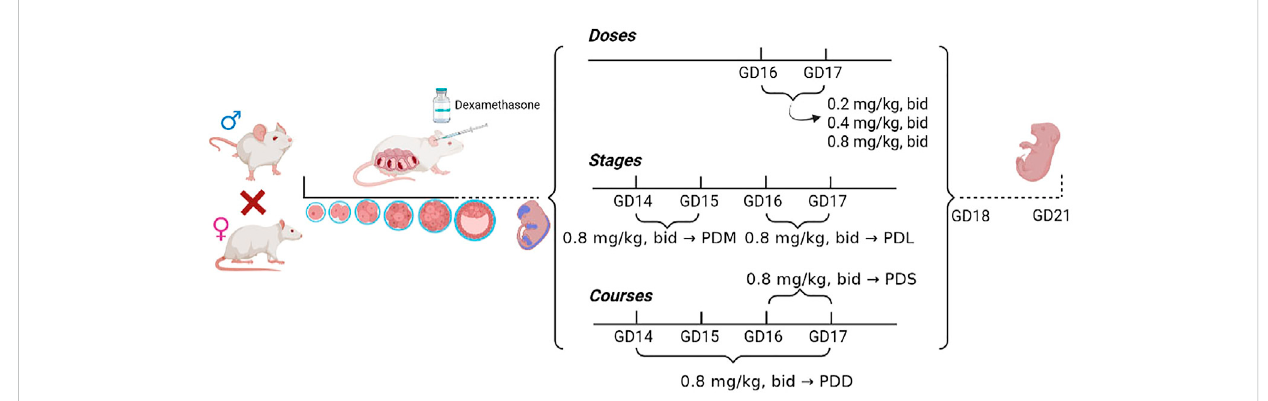
Flow chart of animal experiment processing. PDS, single course of dexamethasone exposure during pregnancy; PDD, double course of dexamethasone exposure during pregnancy; PDM, dexamethasone exposure in the middle-late trimester; PDL, dexamethasone exposure in the late trimester; GD, gestational